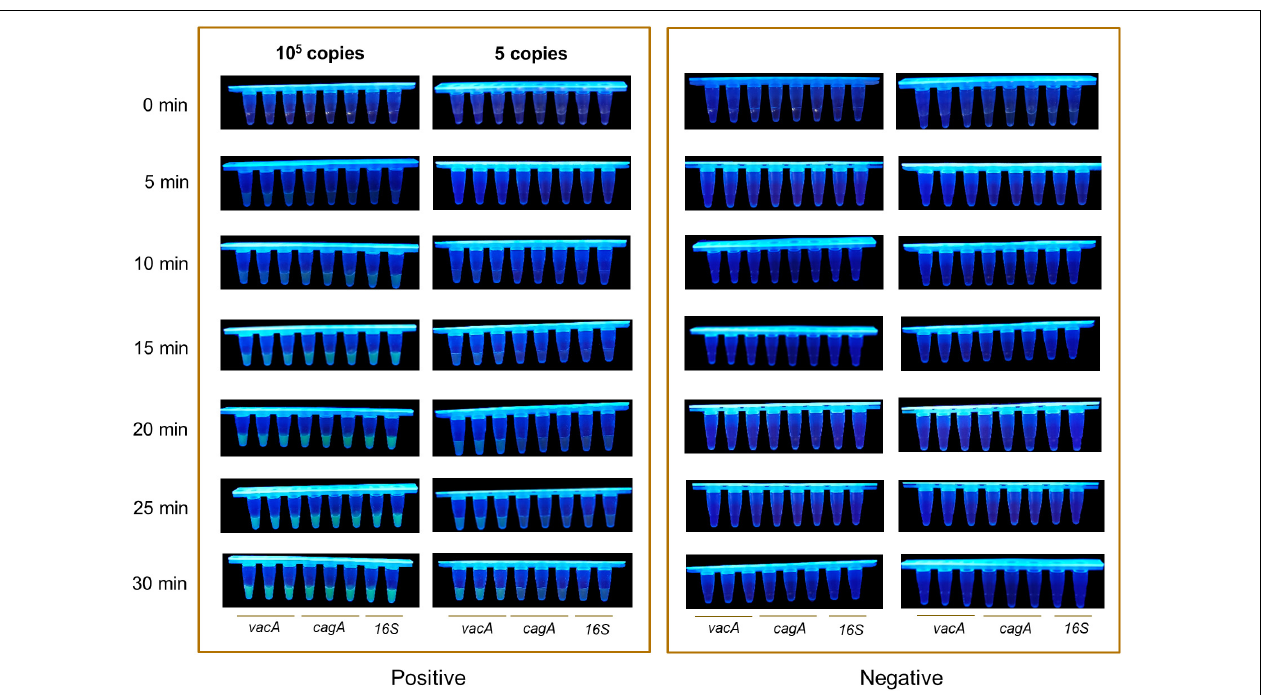
FIGURE 4 | Optimization of the detection time. The visual fluorescence intensity of high and low copy samples detected with the RPA-CRISPR method by Light Cycler 480 fluorescence detection system in 30